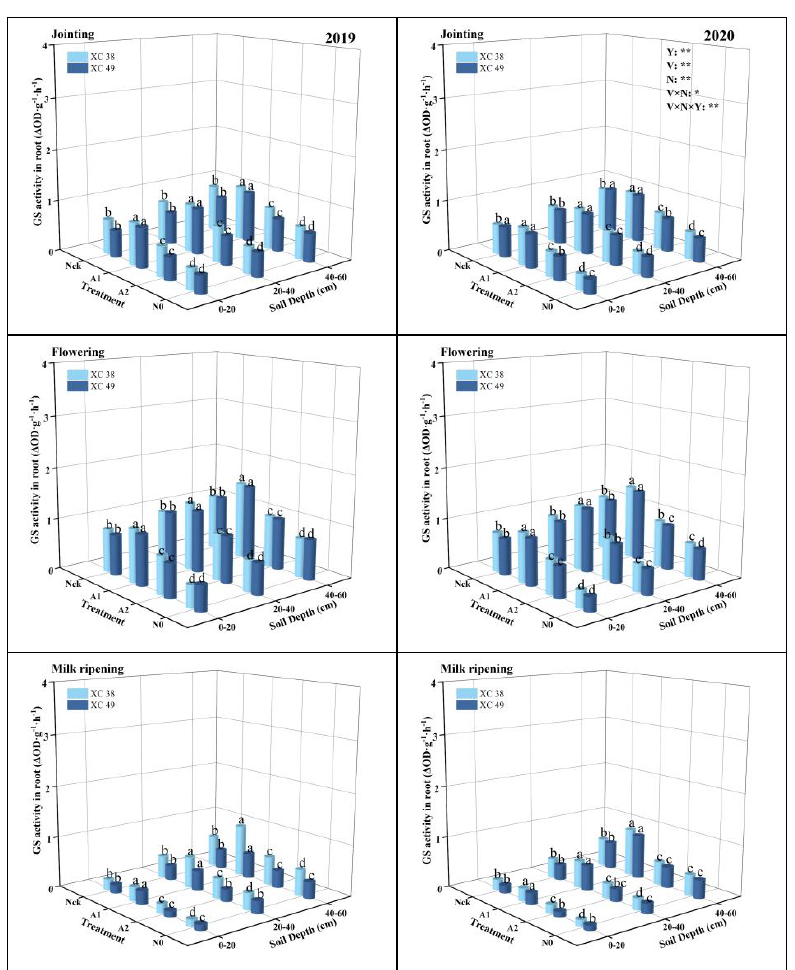
Figure 3. Effect of nitrogen supply on root GS activity of drip-irrigated spring wheat. Note: XC 38: Xinchun 38; XC 49: Xinchun 49. Nck: 300 kg·ha −1 ; N0: 0 kg·ha −1 ; A1: 240 kg·ha −1 ; A2: 210 kg·ha −1 . V: variety, N: different nitrogen treatments, and Y: year. “*” and “**” indicate significant differences at 0.05 and 0.01 levels, ns indicates insignificant differences. Different lowercase letters indicate significant differences between treatments at the 0.05 level.